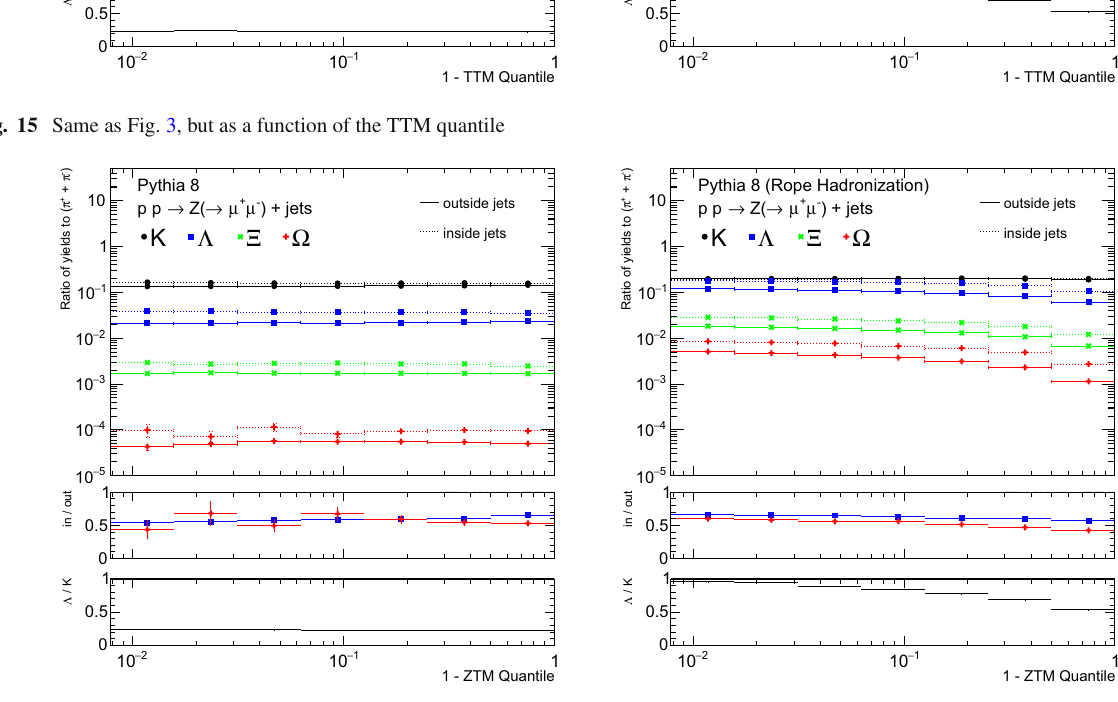
Fig. 16 Same as Fig. 3, but as a function of the ZTM